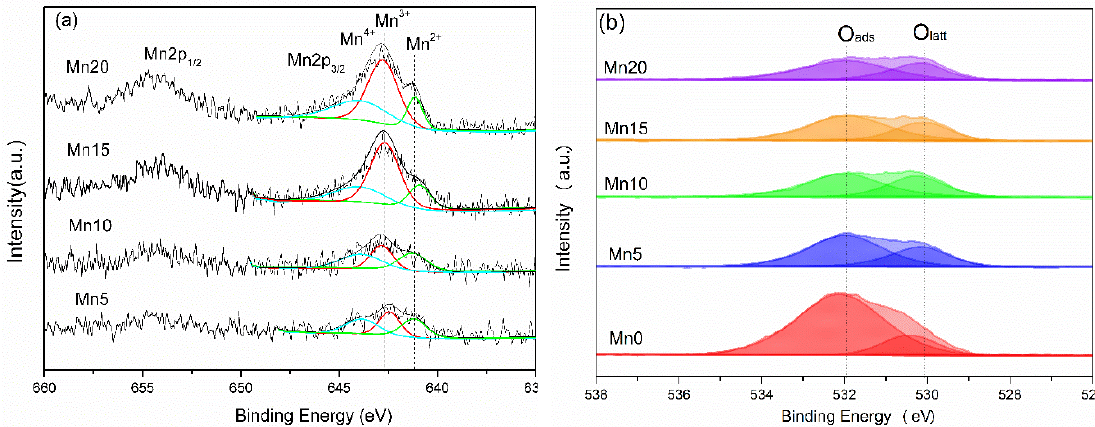
Figure 4. X-ray photoelectron spectroscopy (XPS) spectra for Mn2p ( a ) and O1s ( b ) of the catalysts.